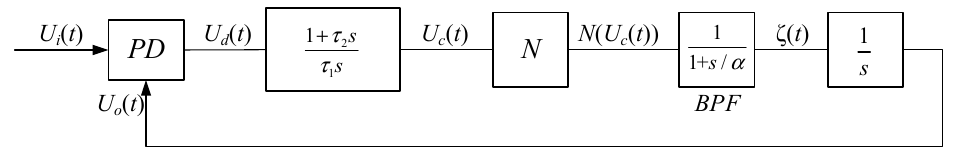
Figure 2. Basic structure of the new nonlinear second-order PLL.